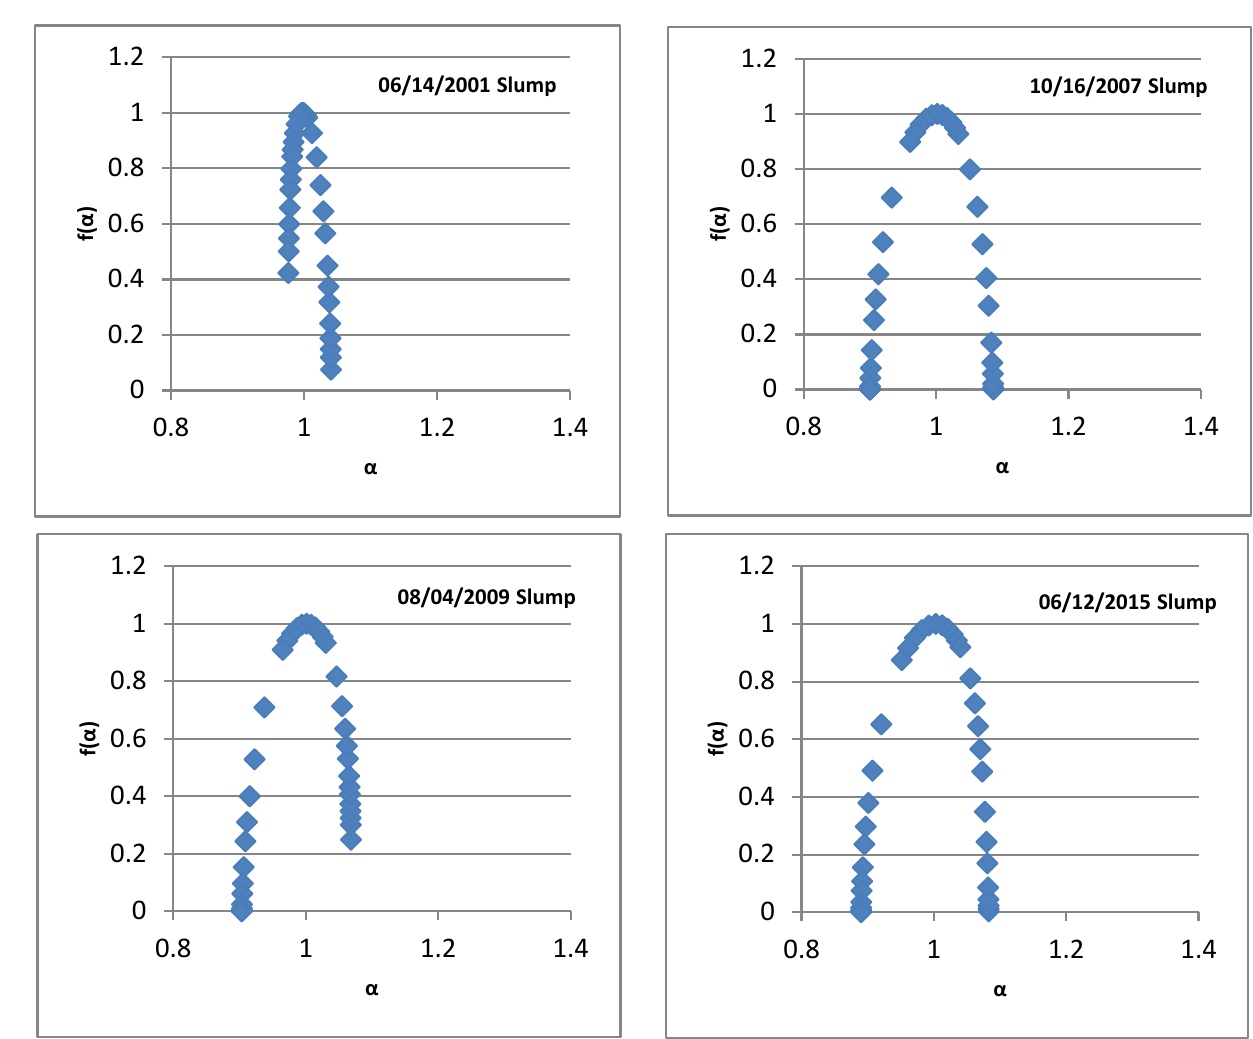
Figure 3. The multi-fractal spectra f( α ) for the slump records of the SSECI. The value of α is determined by the information radiated from the dynamic process of the normalized SSECI, and the range of its value indicates the size of the distribution range of a singular intensity. The spectrum span of the slumps in 1992, 1993, and 1994 are relatively large, indicating that the amplitude of the SSECI are relatively large at that time. Strong multifractal characteristics mean more obvious nonlinear fluctuations. In addition, the asymmetry of the singular spectrum reflects the variation range of the scale index caused by large or small fluctuations. It can be seen from Figure 3 that the singular spectra of the 1992 and 2007 slumps are symmetric, indicating that the scale range of the long range correlation caused by the small or large fluctuation of the SSECI is constant. For the 2009 and 2015 slumps, the peak of the fractal spectrum is right-biased, and its left end is significantly lower than the right end, so the α ~ f( α ) spectrum belongs to the dense distribution of buying power dominated, which means higher normalized prices dominate the multifractal behavior of the SSECI change, and the stock collapse occurs at the time when the SSECI tends to rise. Apart from the 1993, 1994, 1997, and 2001 slumps, the peak of the fractal spectrum is left-biased and the right end is significantly lower than the left end, and the α ~ f( α ) spectrum belongs to the sparse distribution of abnormal prices, which means the lower normalized prices dominate the multifractal behavior of the price change, and the stock collapse occurs at the time when the SSECI tends to